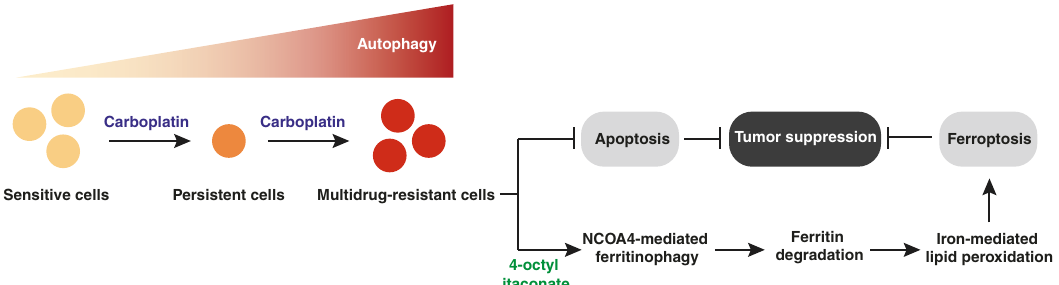
Fig. 6 Schematic summary of targeting autophagy for RB therapy. Persistent cells are a small subgroup of cancer cells that remain viable under carboplatin treatment, leading to multidrug resistance by increasing autophagy activity. Up-regulated autophagy inhibits caspase- mediated apoptosis, but increases the sensitivity of drug-resistant RB cells to ferroptosis. In particular, 4-octyl itaconate activates NCOA4- mediated ferritinophagy, leading to ferritin degradation and subsequent free iron accumulation, and fi nally oxidative damage through the iron-mediated ROS production via Fenton